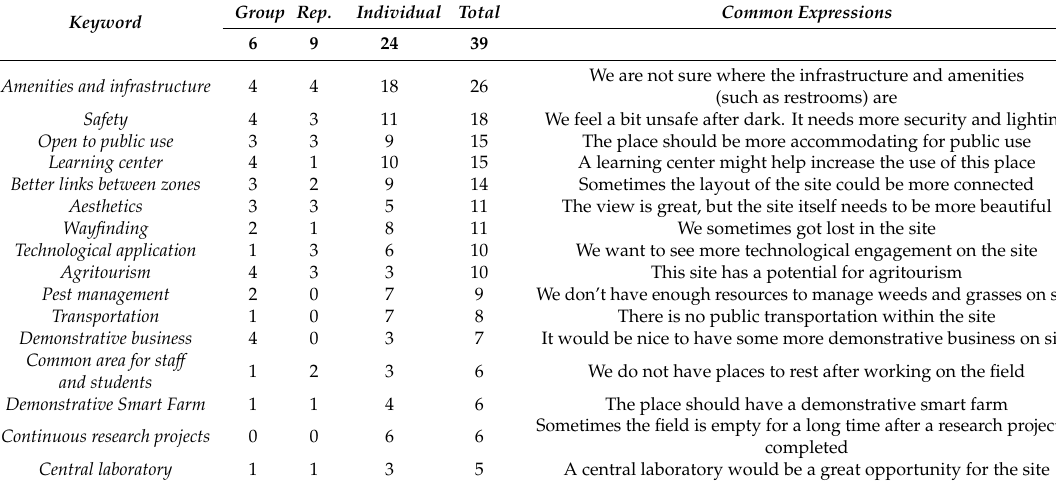
Table 3. Physical-related theme from the